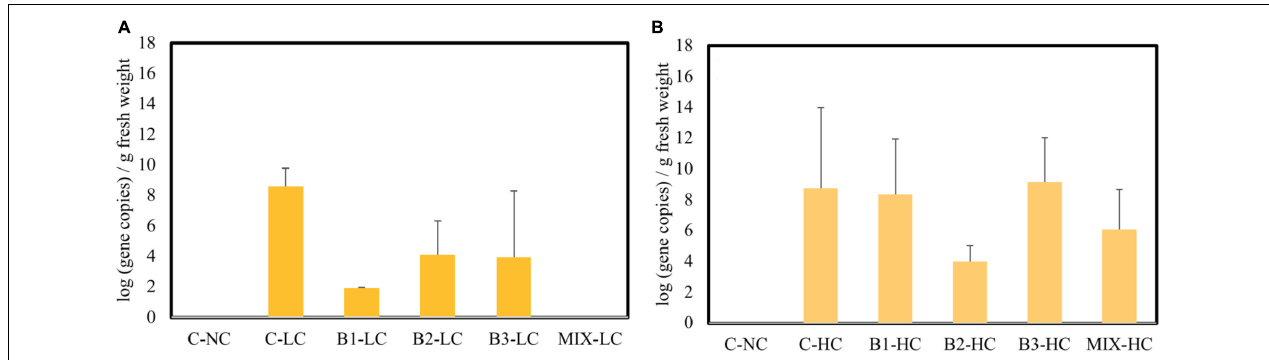
FIGURE 8 | The abundance of sul I gene in the root interior of plants exposed to low (A) high (B) concentration mixture of pollutants ( n = 3); data with asterisk are significantly different ( p < 0,05) compared to the non-inoculated